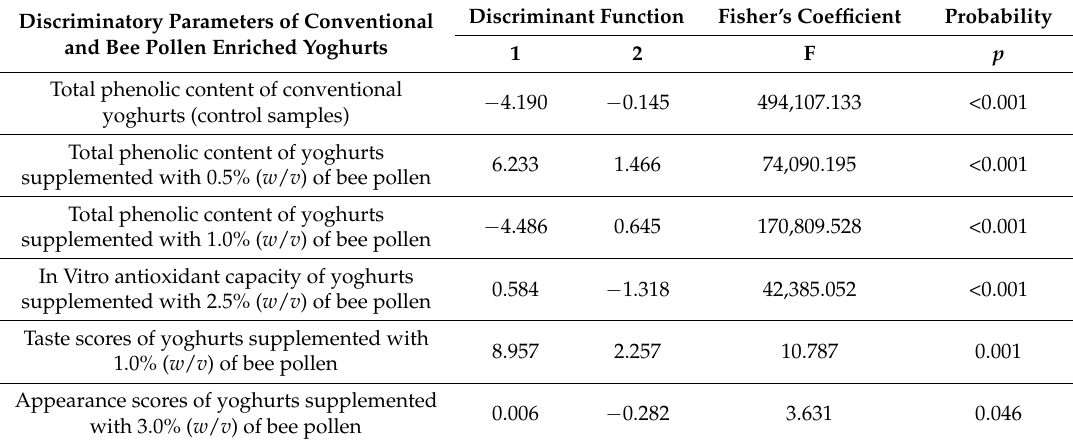
Figure 3. Classification of conventional and bee pollen enriched yoghurts with respect to milk type. Table 5. Standardized canonical discriminant function coefficients of the developed statistical model for the discrimination of conventional and bee pollen enriched